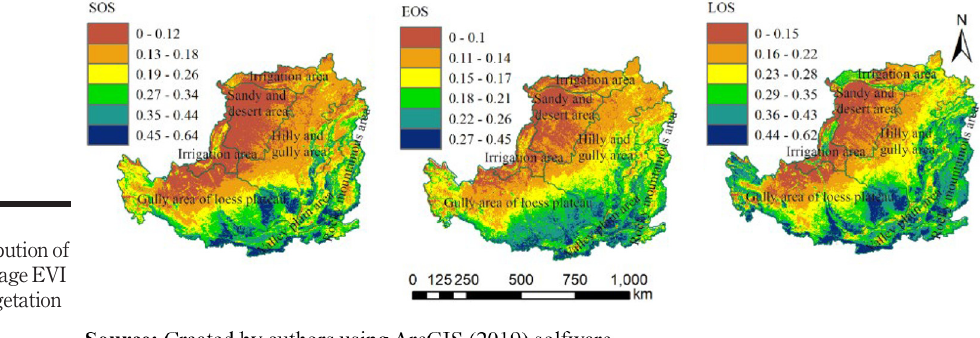
Figure 5. Spatial distribution of monthly average EVI values for vegetation